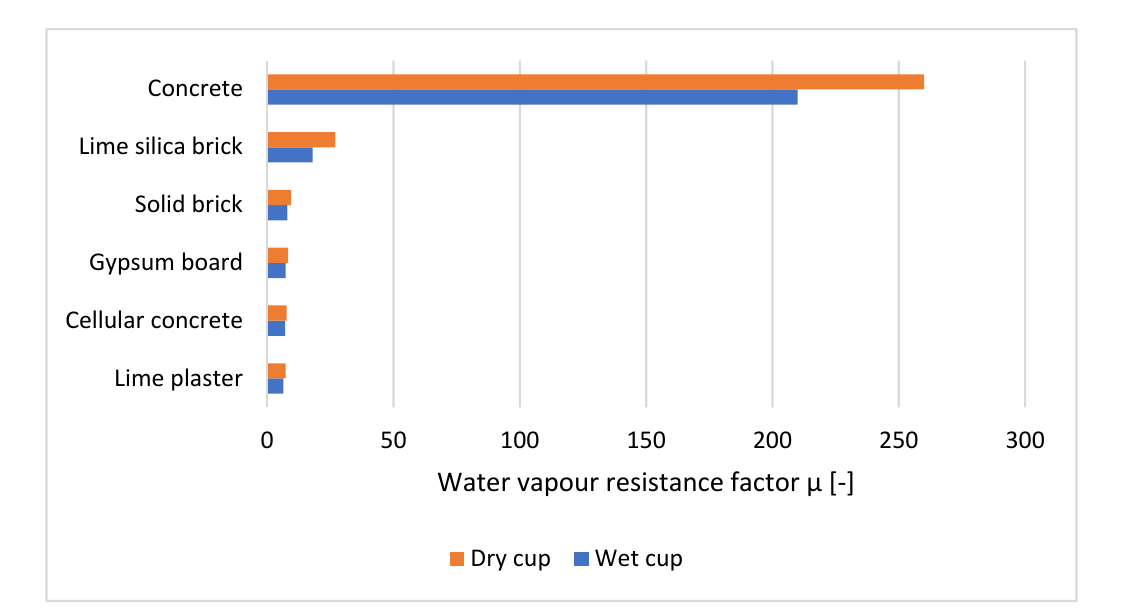
Figure 3. Water vapour resistance factor of building materials [39].